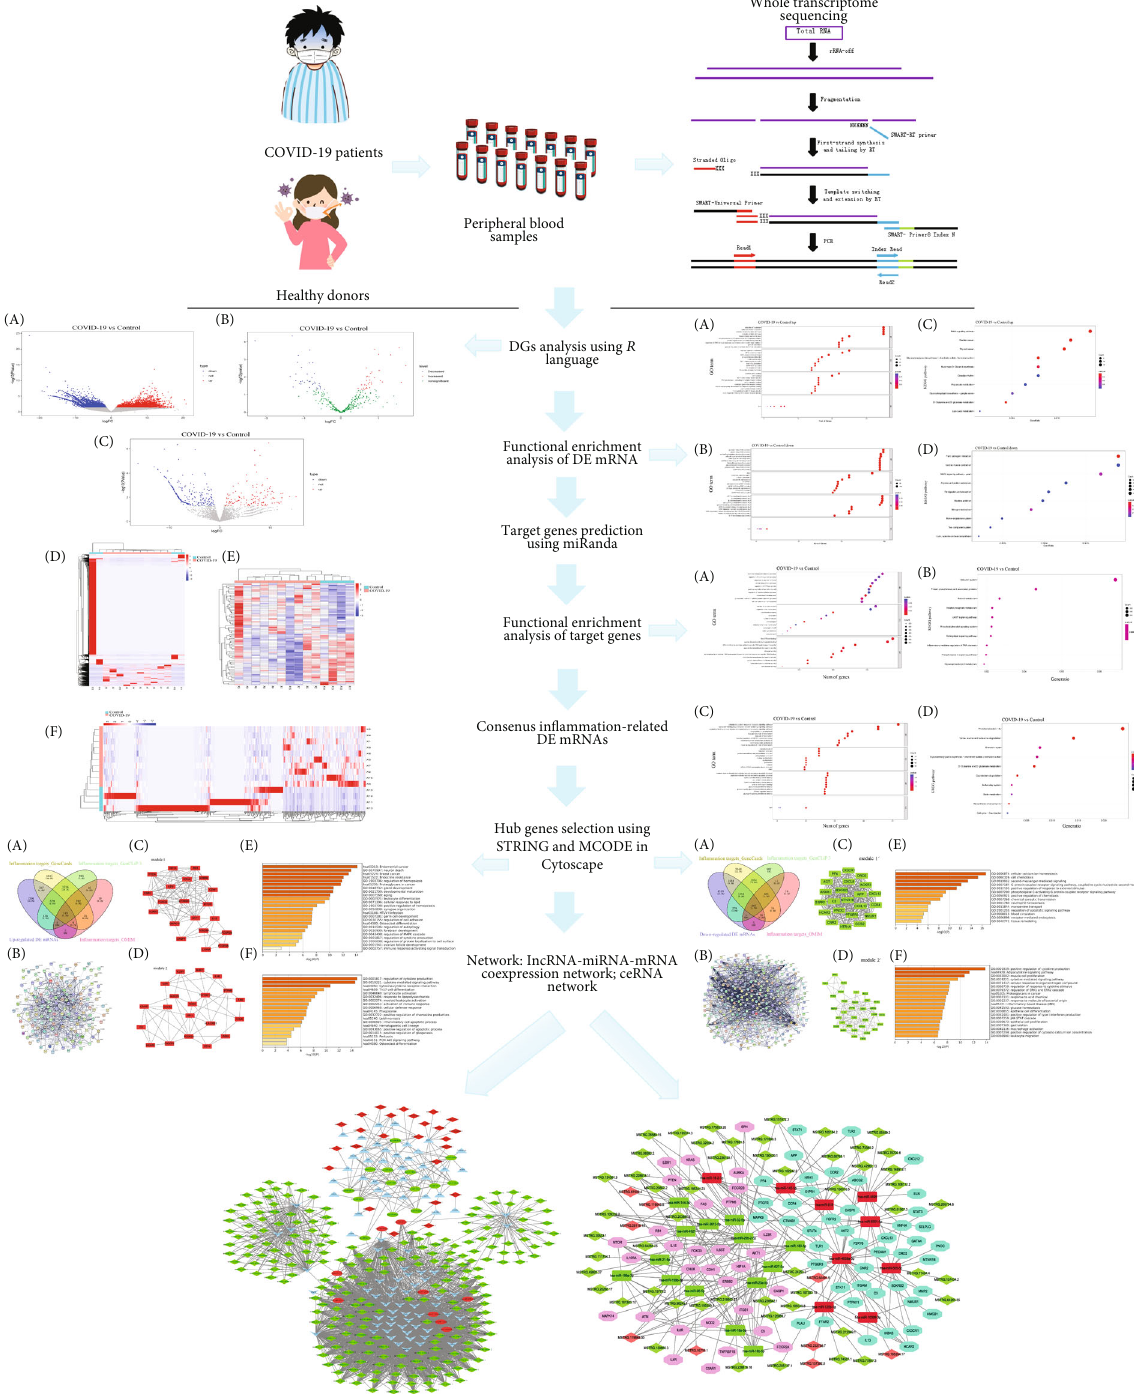
Figure 1: The work fl ow of the Whole-transcriptome RNA sequencing analysis of peripheral blood samples of COVID-19